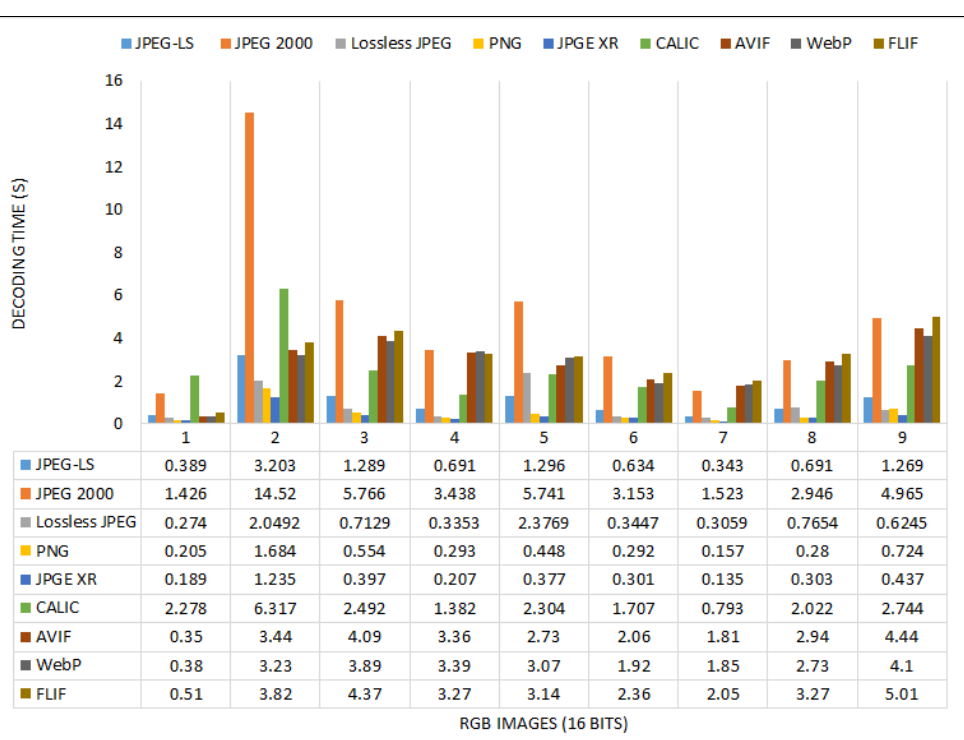
Figure 25. Comparison of decoding times for 16-bit RGB